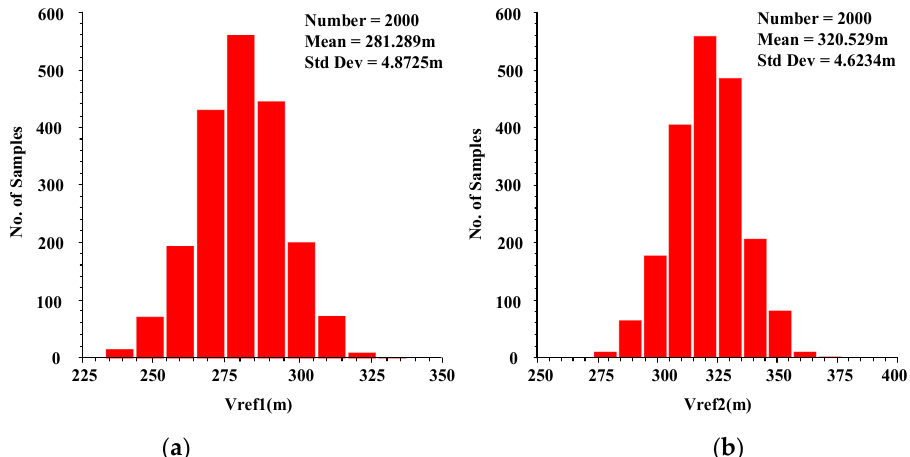
Figure 3. Monte Carlo simulation of output voltages for 2000 samples: ( a ) simulation Vref1 ; and ( b ) simulation Vref2 .